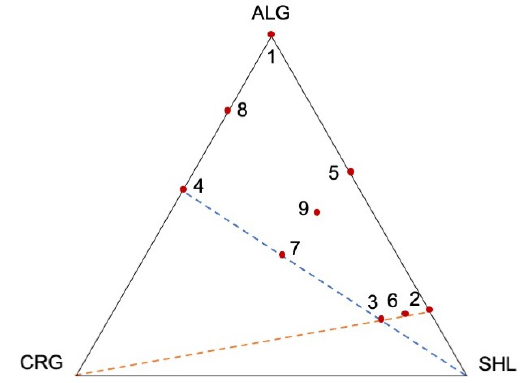
Figure 6. Constraints and experimental points